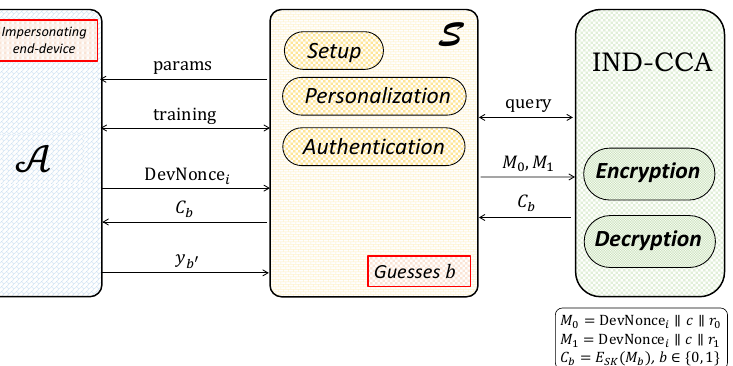
Figure 8. The game among A , impersonating the network server; S ; and IND-CCA oracles. Lemma 3. The proposed method is resistant to an adversary who recovers the session